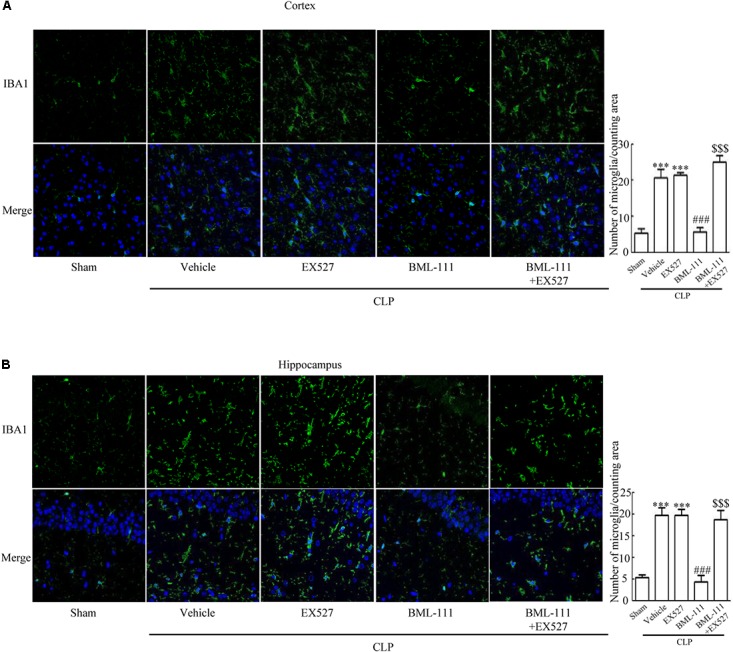
BML-111 decreases the activation of microglia induced via SIRT1 in CLP. (A,B) CLP and EX527 increased the activated microglia compared with sham group, and there did not differ between CLP + Vehicle group and CLP + EX527 group. BML-111 decreased the activated-microglia than in CLP + Vehicle group. EX527 treatment before CLP and BML-111 increased the activated microglia when compared with the CLP + BML-111 group. Scale bars indicate 50 μm (n = 3 surviving mice per group). ∗∗∗P < 0.001 represent CLP + Vehicle vs. Sham and CLP + EX527 vs. sham, ###P < 0.001 represent CLP + BML-111 vs. CLP + Vehicle,$$$P < 0.001 represent CLP + BML-111 + EX527 vs. CLP + BML-111.